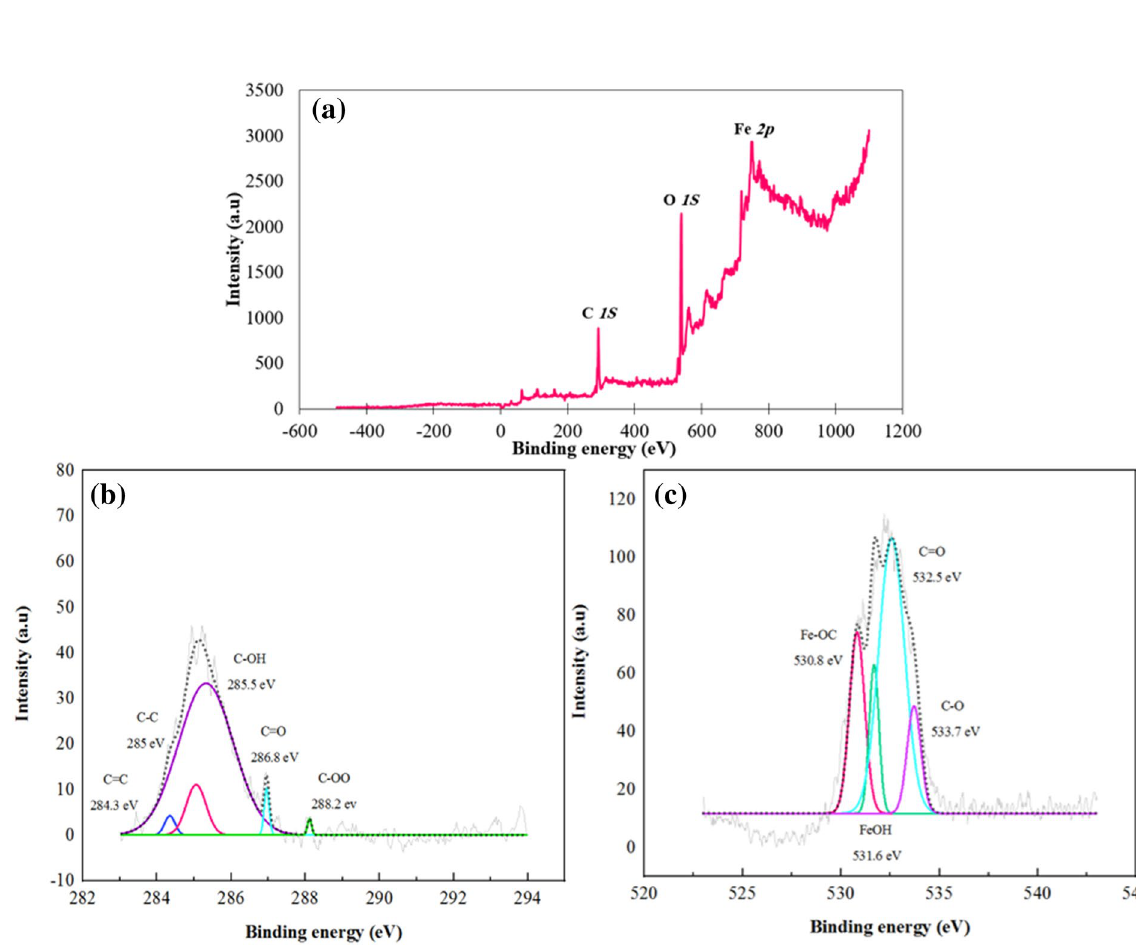
Figure 14. XPS survey spectrum ( a ) along with C 1s ( b ) and O 1s ( c ) high-resolution spectra for MS exposed to the GSE solution for 3